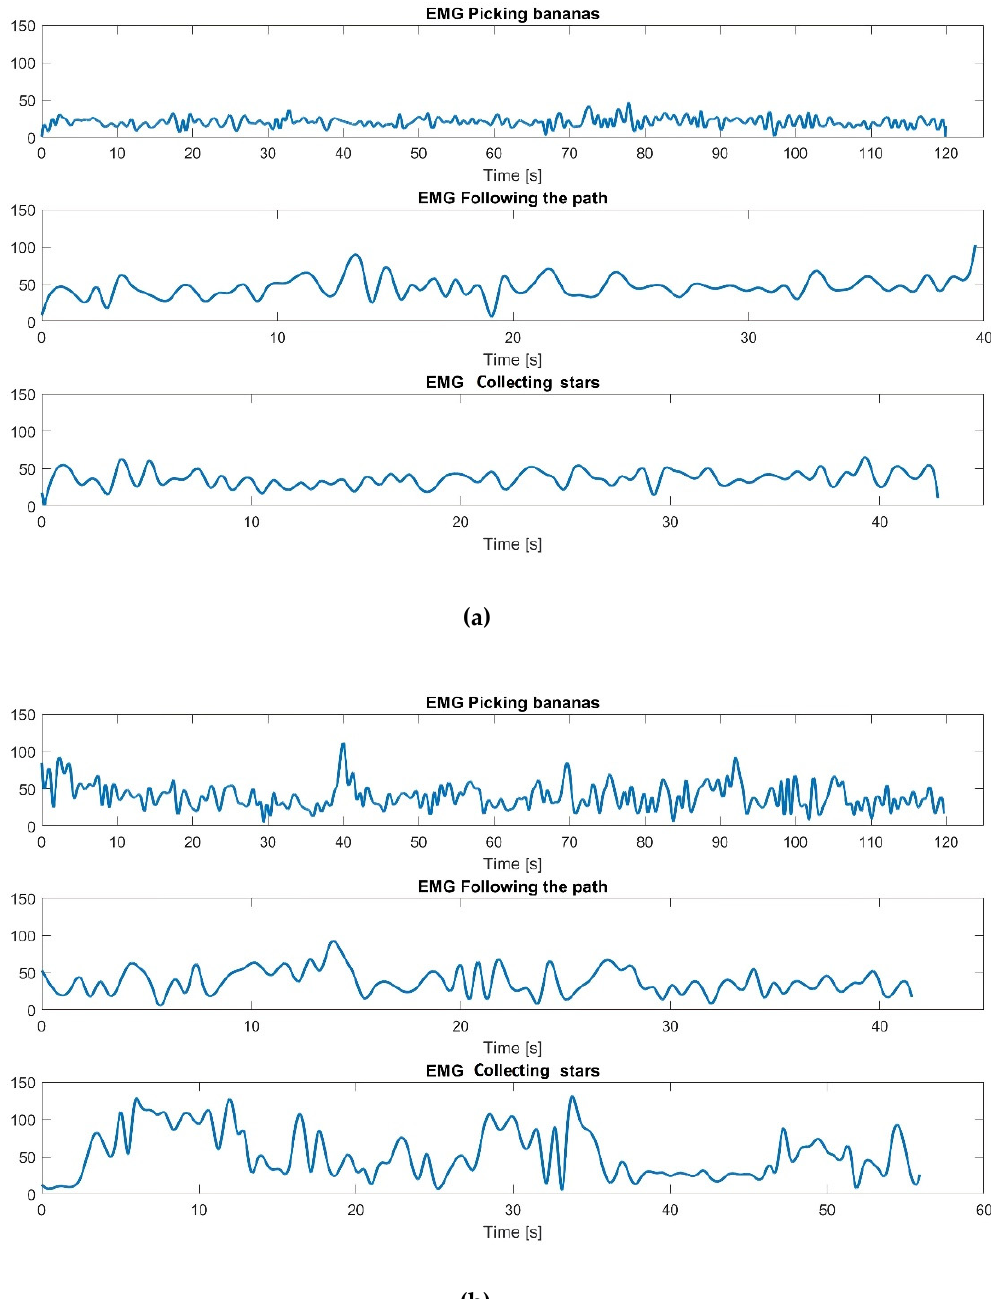
Figure 8. Activation pattern in the flexors and extensors muscles from Novint Falcon device placed on the forearm for the three serious games for ( a ) a healthy subject and ( b ) an SCI patient. The information provided by the Myo Gesture armband is unitless, with a potential value in the range of [0,255]. EMG =